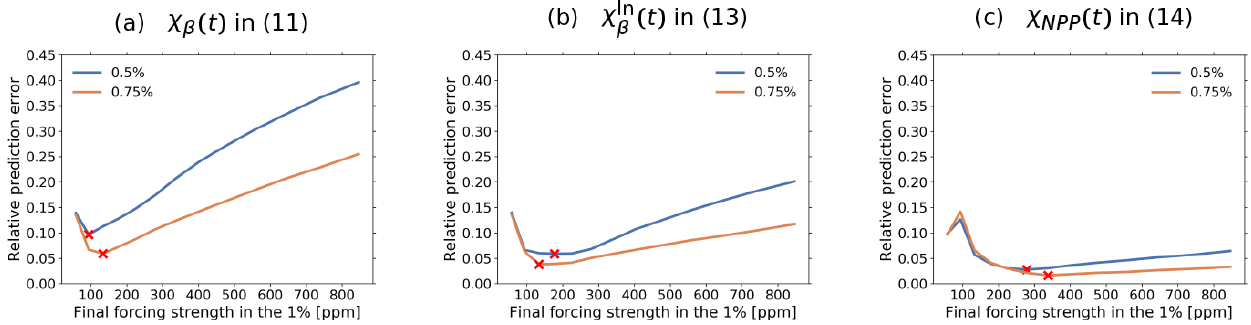
(t) and χ NPP (t) β